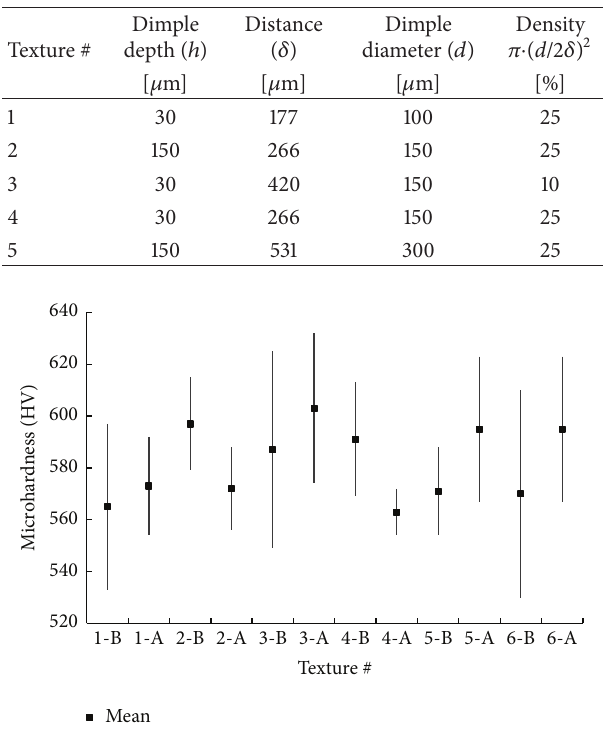
Figure 6: Microhardness Vickers measured in point (2) near the die radius for all textures before (B) and after (A) hot stamping tests: maximum, mean, and minimum values.